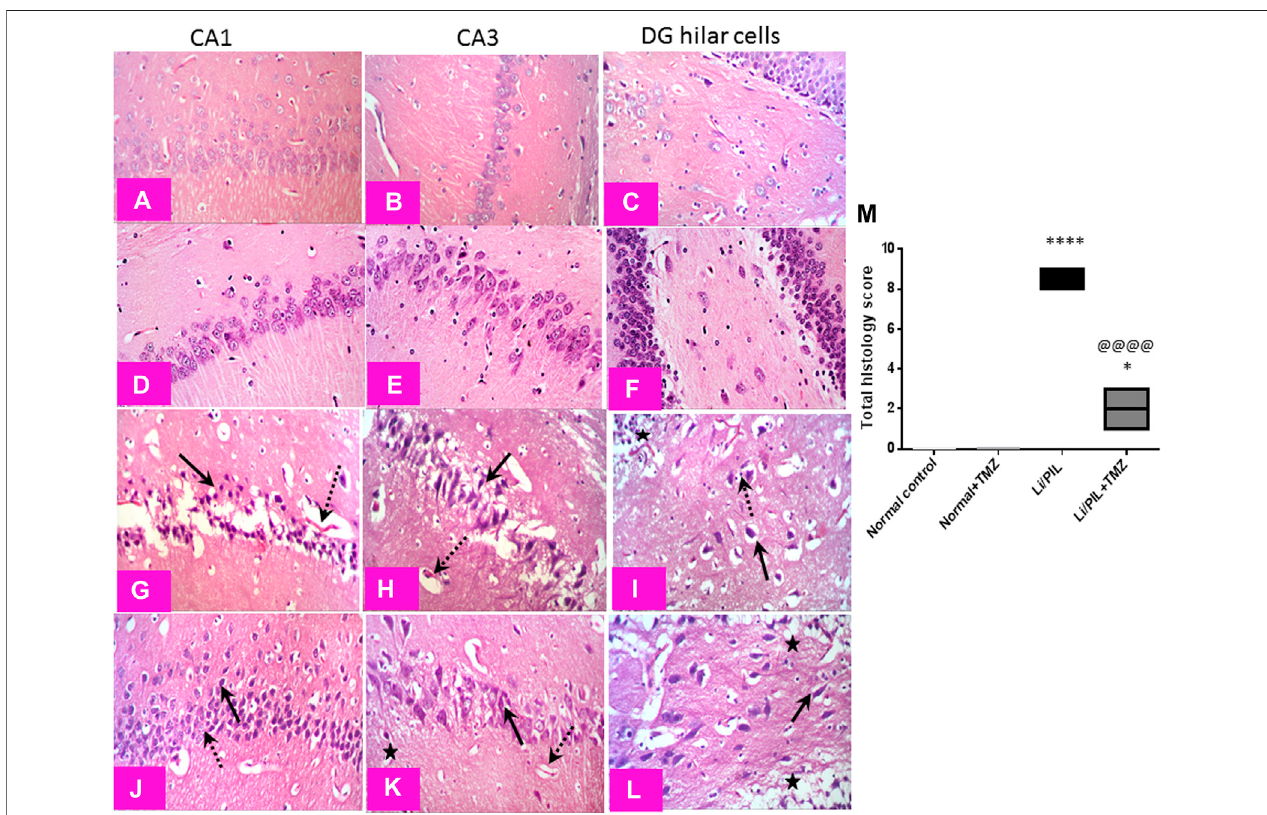
FIGURE 7 | Effect of TMZ on histopathological alterations in the hippocampi of rats with Li/PIL-induced seizures ( × 400 original magni fi cation). Normal control rats and normal rats treated with TMZ showed normal histology of CA1, CA3, and hilar regions (A – C) and (D – F) , respectively. Li/PIL control showed a signi fi cant loss of pyramidal cells layer (dotted arrows), many apoptotic fi gures, edema (star), and sloughing of capillary endothelium in CA1 and CA3 regions (arrows); in addition to many degenerated neurons (arrow), pyknotic nuclei, and glial cells in fi ltration (dotted arrow) (G,H) , and edematous fl uid effusion and congested blood capillaries in the hilar region (I) . TMZ + Li/PIL rats demonstrated partial protection with less edema fl uid and congested capillaries (star), more organizing effect on pyramidal cells in CA1 andCA3regionswithmixedarrangementoffewerdamaged(arrow)andintact(dottedarrow)neurons (J,K) ,andlowernumberofdegeneratedandapoptoticneuronsin the hilar region (arrow) (L) . (M) Total histology lesion score; data are expressed as box plots of the median of three animals. Statistical analysis was done using the Kruskal – Wallis test followed by Dunn ’ s test. *Signi fi cantly different from the normal control group (Saline) at p < 0.05; ****Signi fi cantly different from the normal control group (Saline) at p < 0.0001; @@@@ Signi fi cantly different from the Li/PIL control group at p <